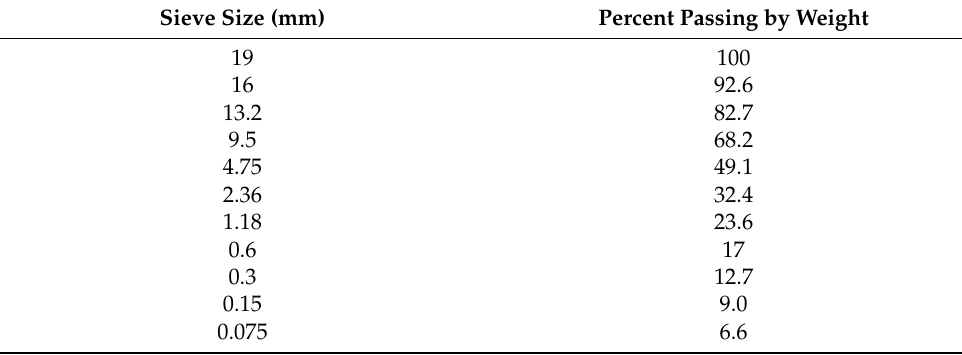
Table 4. The grading of